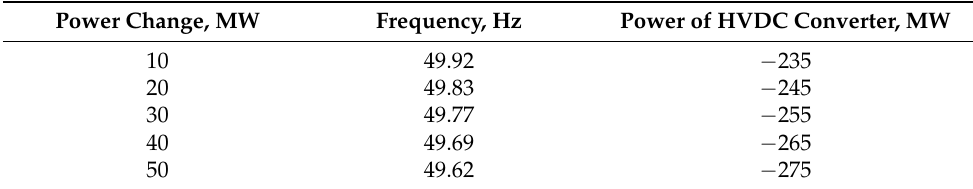
Figure 6. ( a ) Frequency change in the isolated power system caused by a load increase (case A). ( b ) Voltage fluctuations on the 330 kV side caused by a load increase (case A). Table 3. Frequency change in the isolated power system.